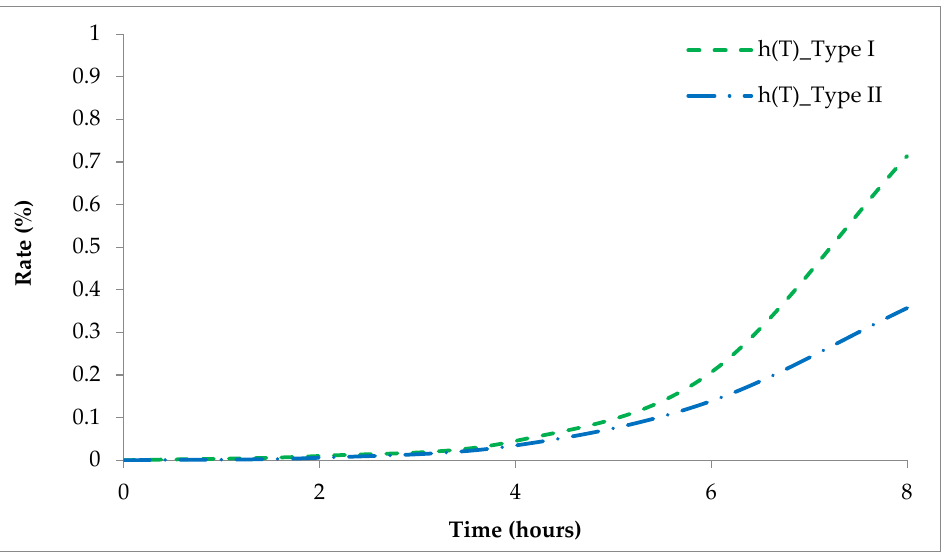
Figure 10. Comparative analysis of the hazard rate functions for the analyzed milling teeth.